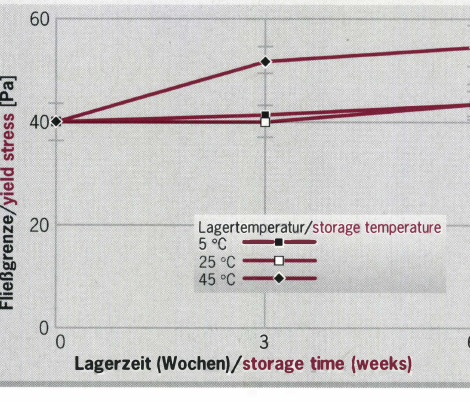
preparation on the flow properties